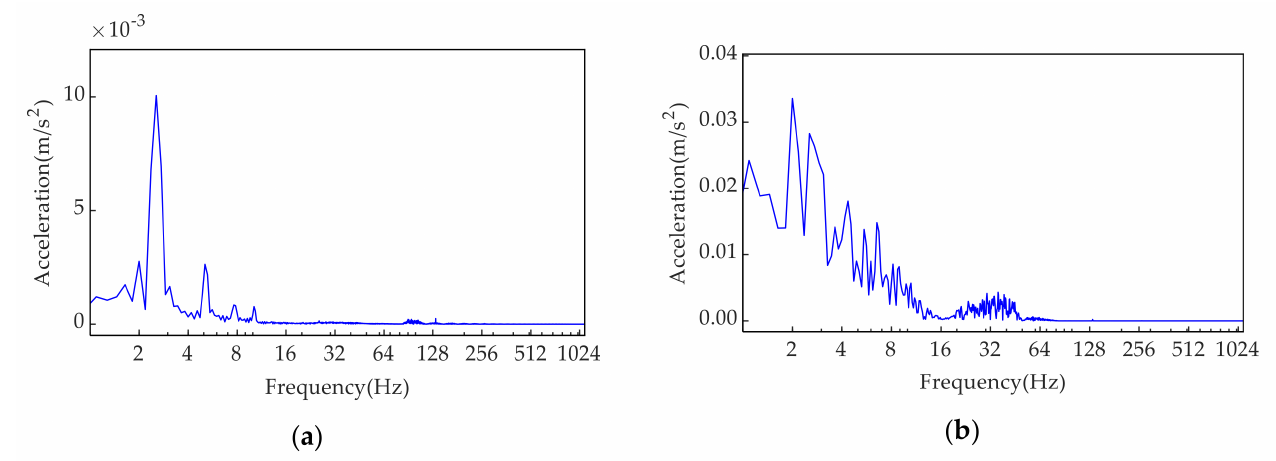
Figure 14. Frequency distribution of the vertical acceleration of the car body under: ( a ) track short wave irregularity; ( b ) track medium-long wave irregularity.